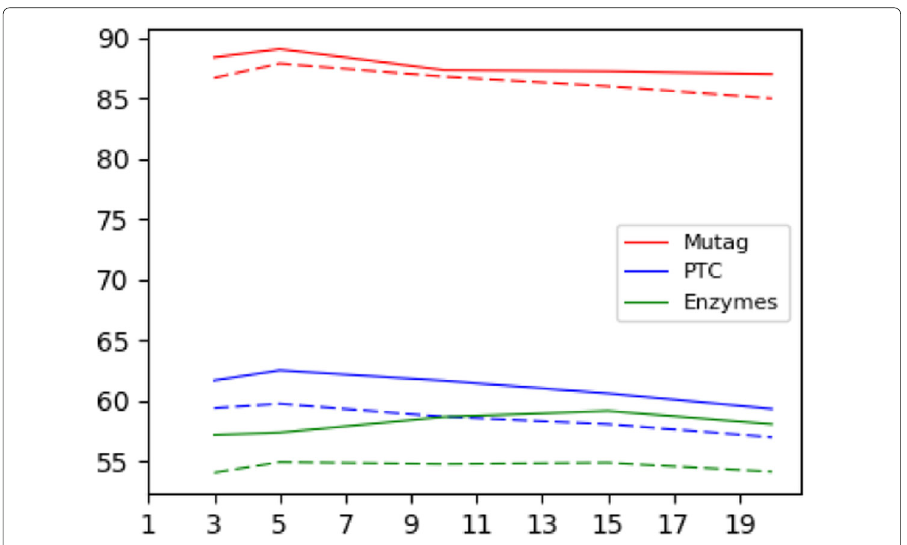
Fig. 9 Random walk length ( x axis) vs graph classification accuracy ( y